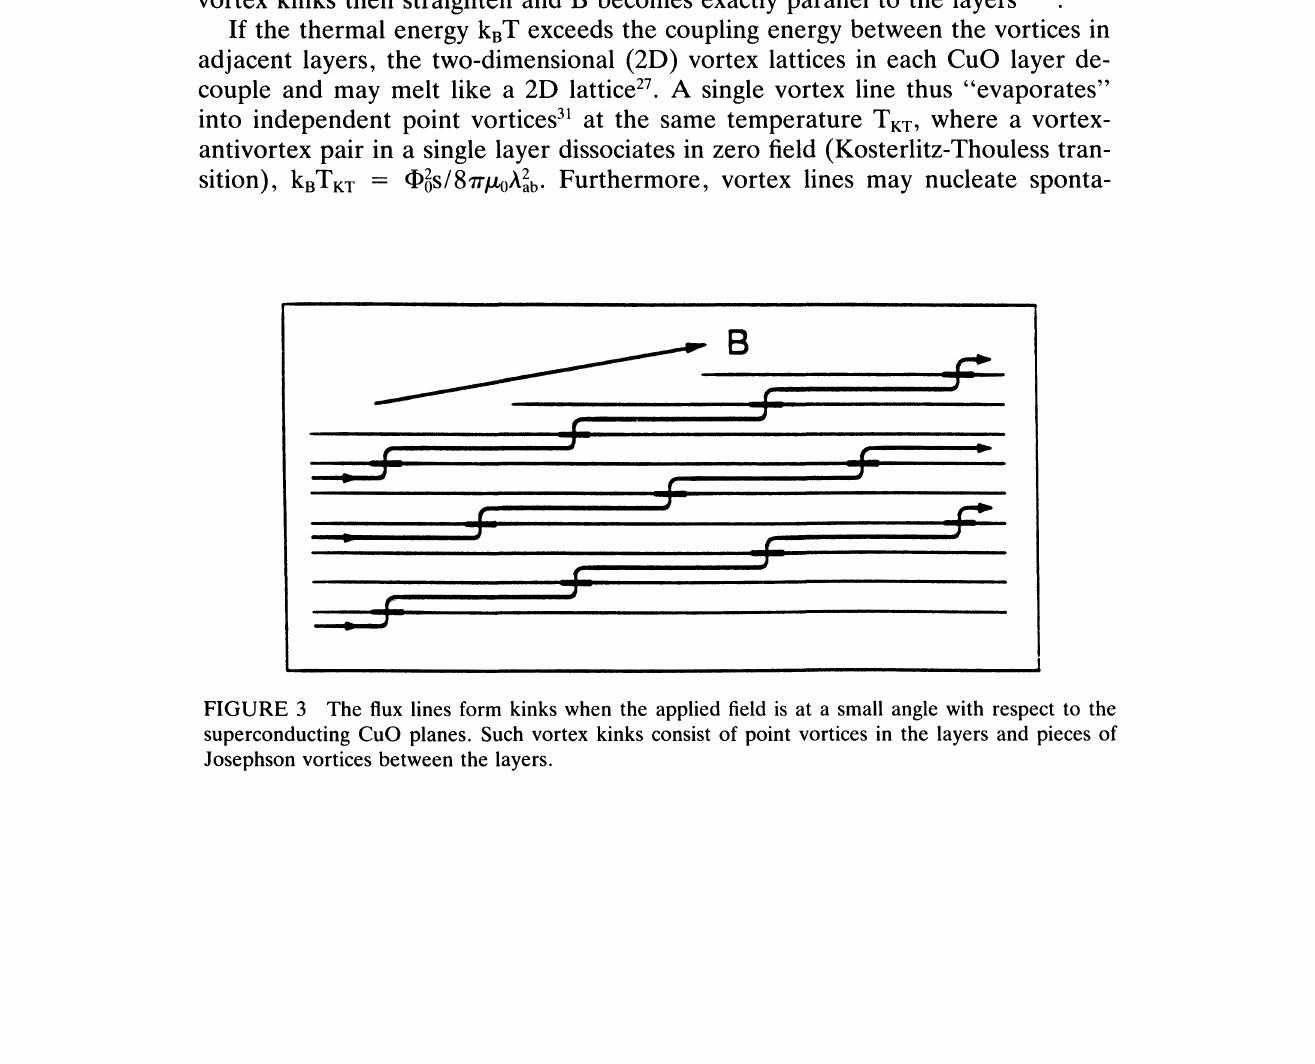
FIGURE 3 The flux lines form kinks when the applied field is at a small angle with respect to the superconducting CuO planes. Such vortex kinks consist of point vortices in the layers and pieces of Josephson vortices between the